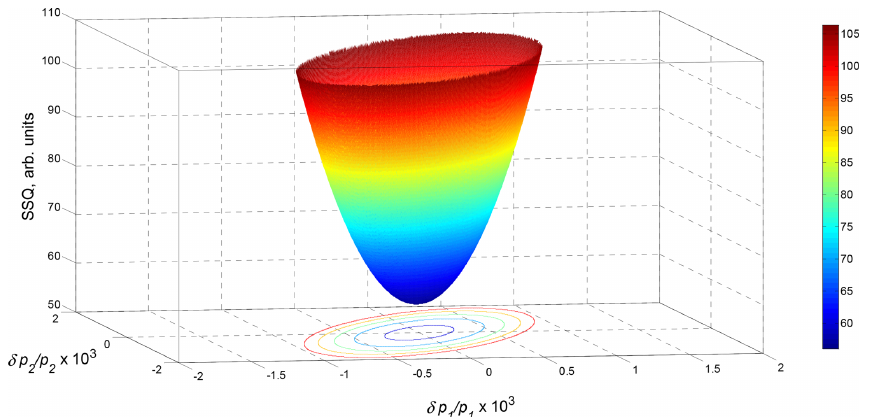
Figure 6. Example of the environment of SSQ min of the special case of AT-cut quartz TSM resonator with a 5µm thick Cu layer that is in contact with glycerol. The varied material parameters are mass density ( p 1 ) and shear modulus ( p 2 ) of the Cu layer. The incorporated measurements comprise all resonant and anti-resonant frequencies and FWHMs until the 16th overtone (except 2nd and